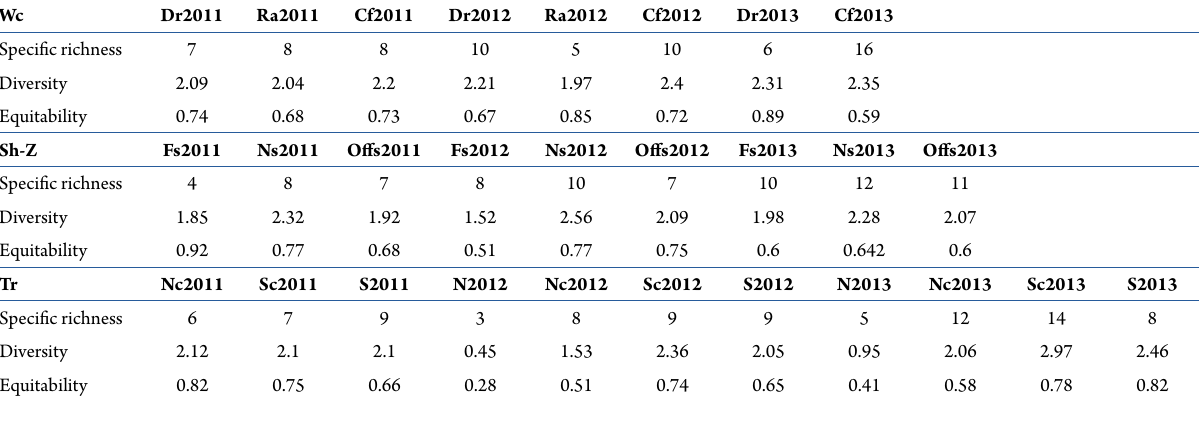
Table 7. Specific richness (Sr), diversity (H) and evenness of Brachyura zoea I community per weather condition (Wc), transects (Tr) and shore zone (Sh-Z). Cold fronts, Cf; Dry, Dr; Foreshore, Fs; North central zone, Nc; Nearshore, Ns; northern zone, N; Offshore, Offs; Rainy, Ra; Southern zone S; South central zone, Sc. Wc Dr2011